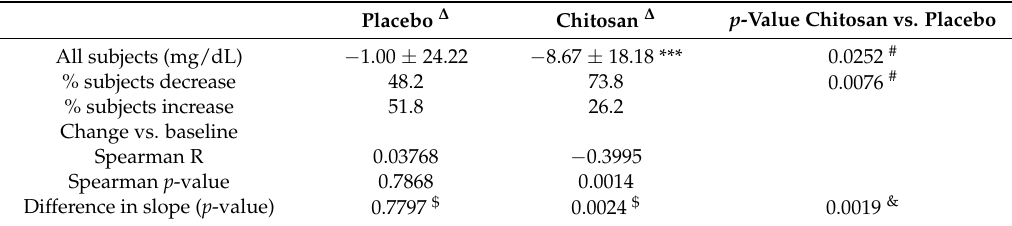
Table 5. Comparison of changes in serum low density lipoprotein (LDL) cholesterol induced by chitosan and placebo treatments.